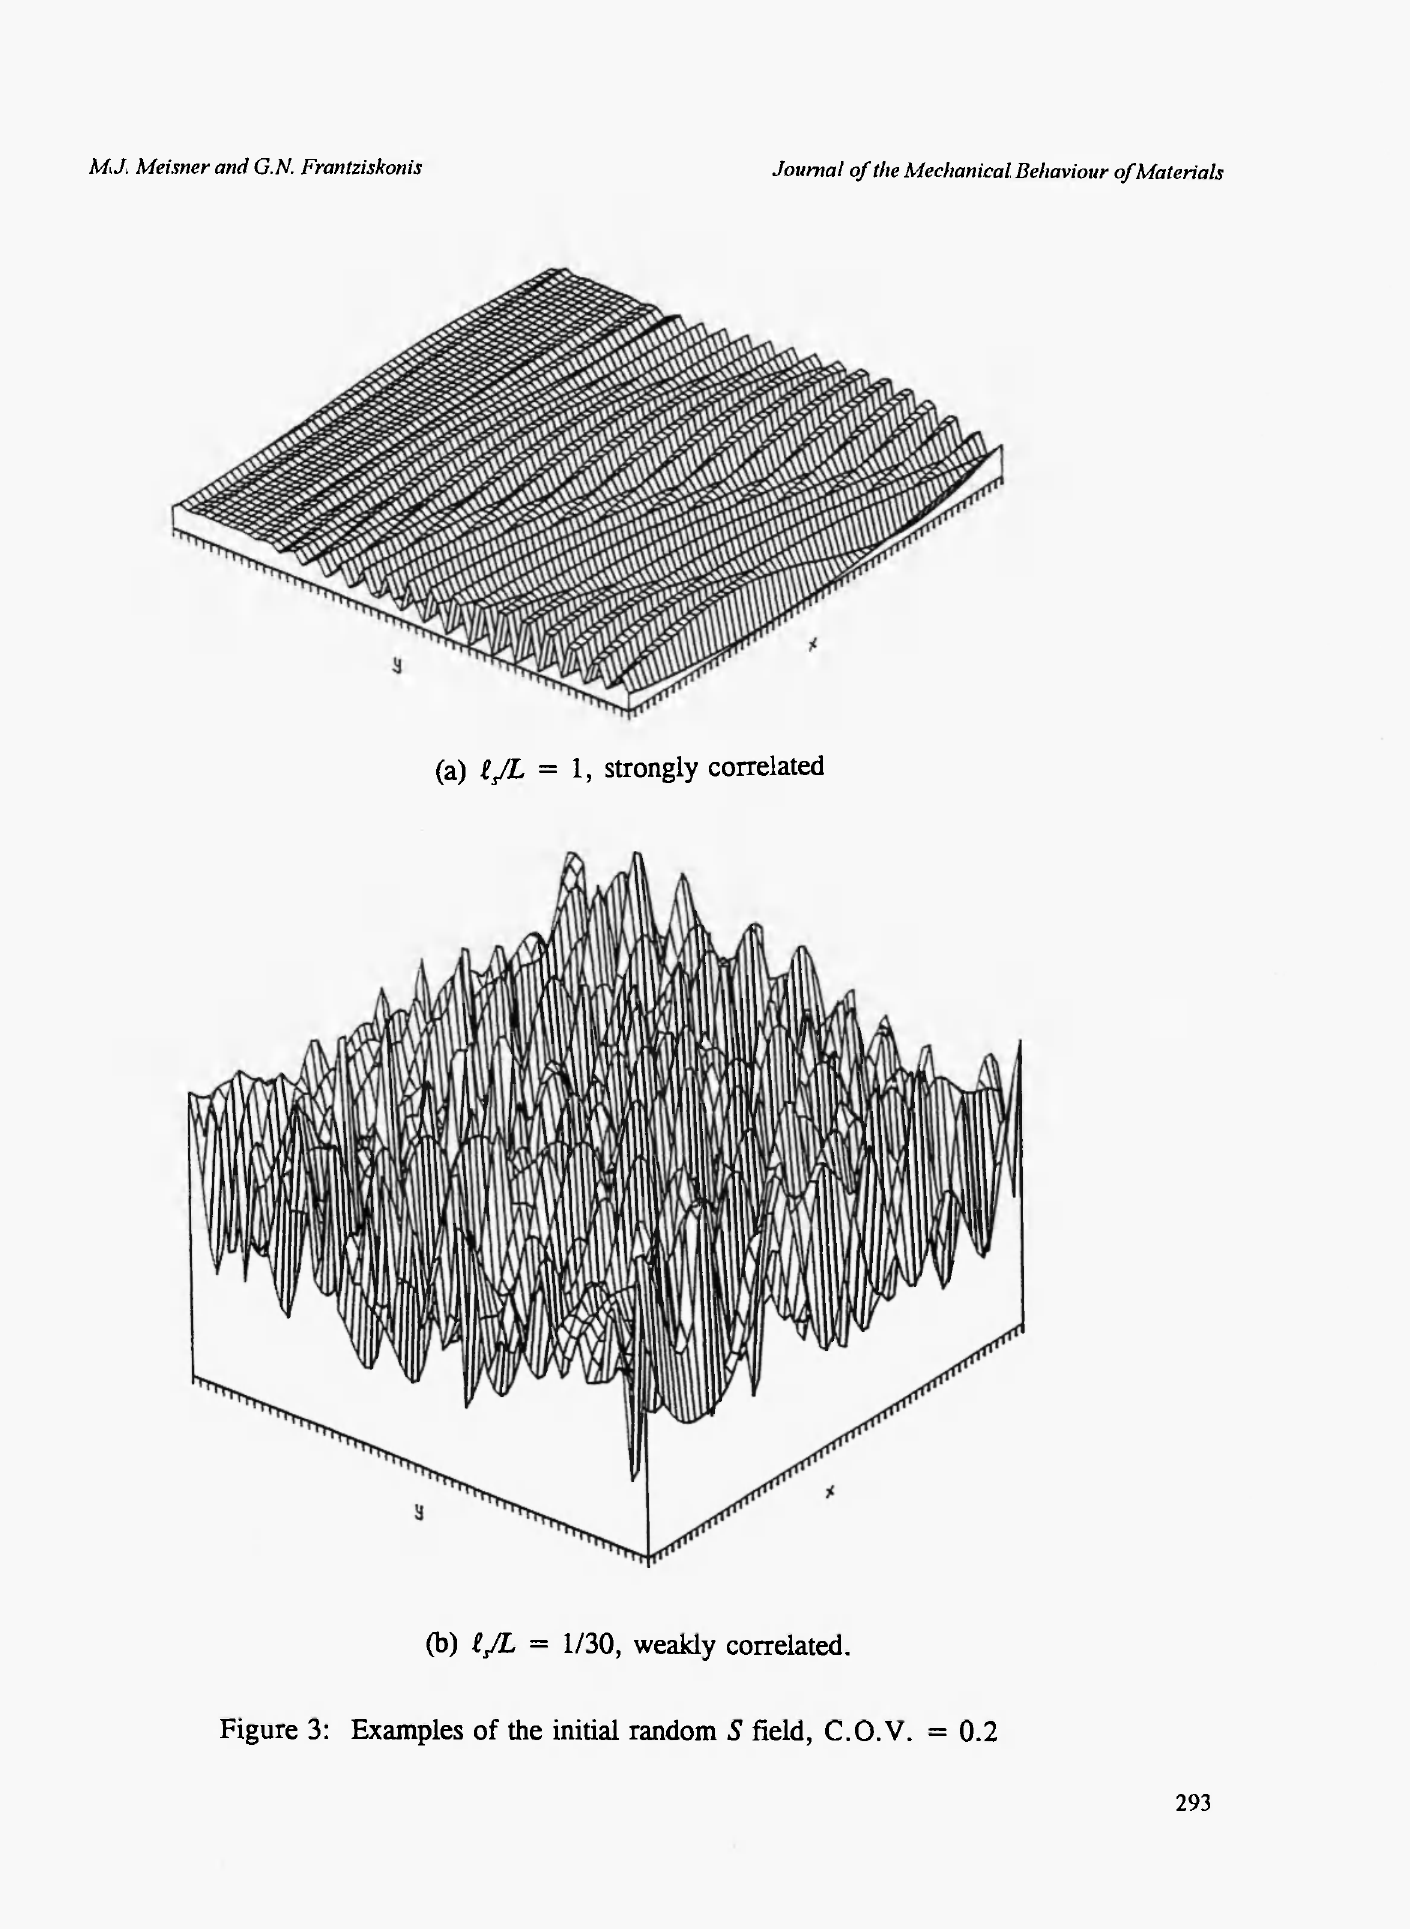
Figure 3: Examples of the initial random S field, C.O.V. =